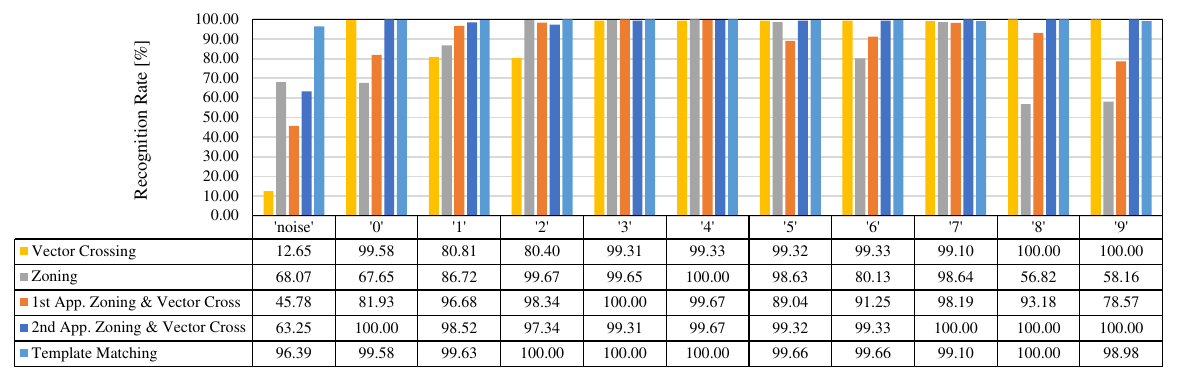
Fig. 7 Recognition rate per character for the four proposed